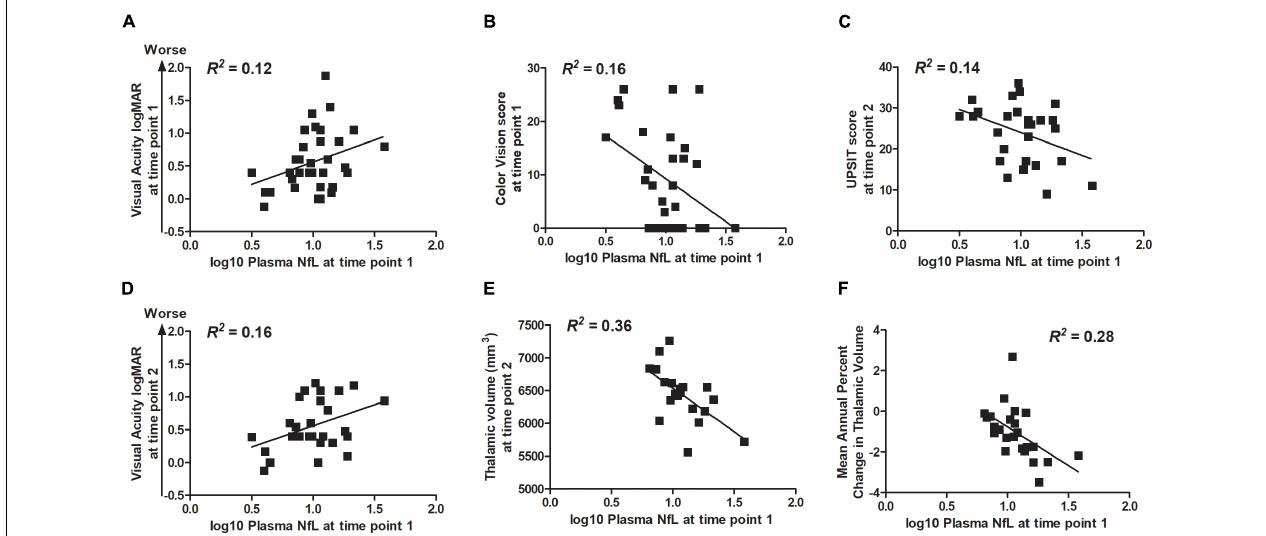
FIGURE 3 | Within the Wolfram group, higher log10 plasma NfL levels at time point 1 related to (A,B) worse visual acuity and color vision at time point 1; (C–E) worse visual acuity and color vision (data not shown), less accurate smell identification, and smaller thalamic volume at time point 2; and (F) faster rate of annual decrease in thalamic volume.